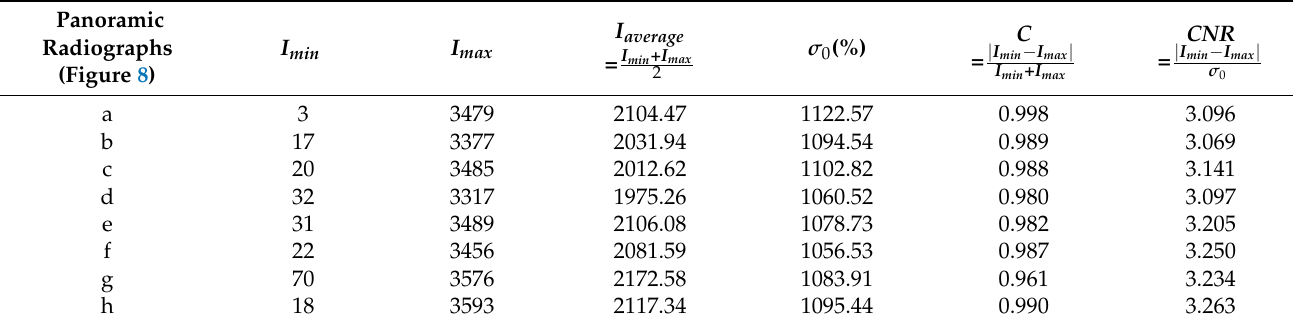
Table 2. Highest, lowest, and average values of pixel intensity I , C , CNR , and standard deviation of pixel intensity ( σ 0 ), all related to the optimization process shown in Figure